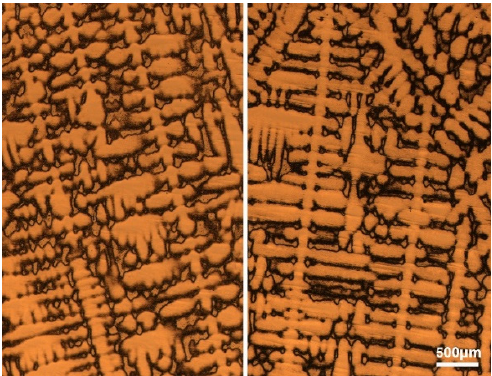
Figure 10. Typical dendrite morphologies in the columnar zone.